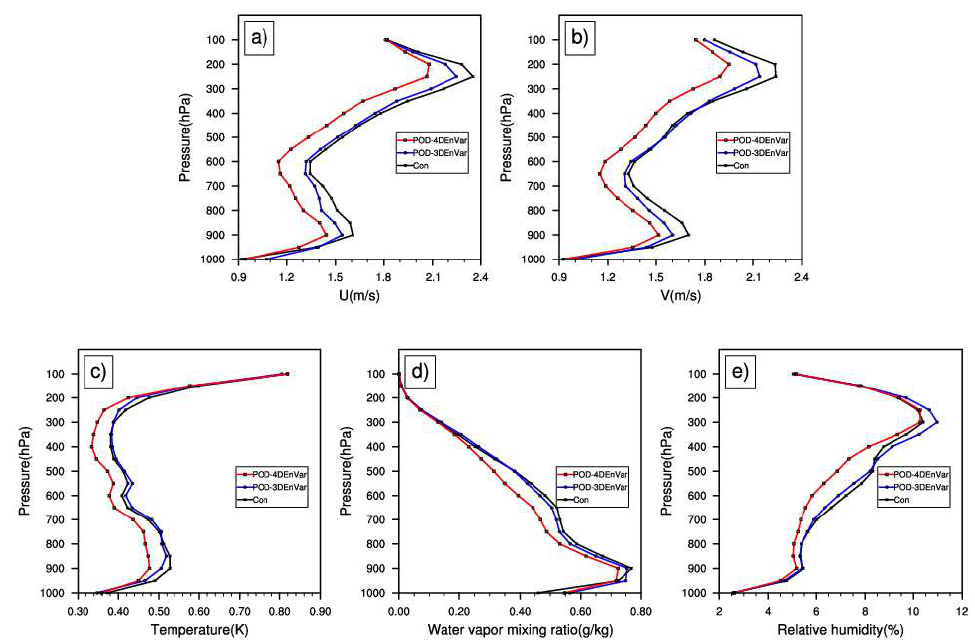
Figure 6. Vertical profiles of root-mean-square errors (RMSEs) in ( a ) u winds (unit: m s −1 ) ( b ) v winds (unit: m s −1 ) ( c ) temperature (unit: K) ( d ) water vapor mixing ratio (unit: g/kg) ( e ) relative humidity (unit: %) from Con, POD-3DEnVar, and POD-4DEnVar. Results are valid at 00:00 UTC on 29 June 2009 and are calculated for the whole horizontal domain.